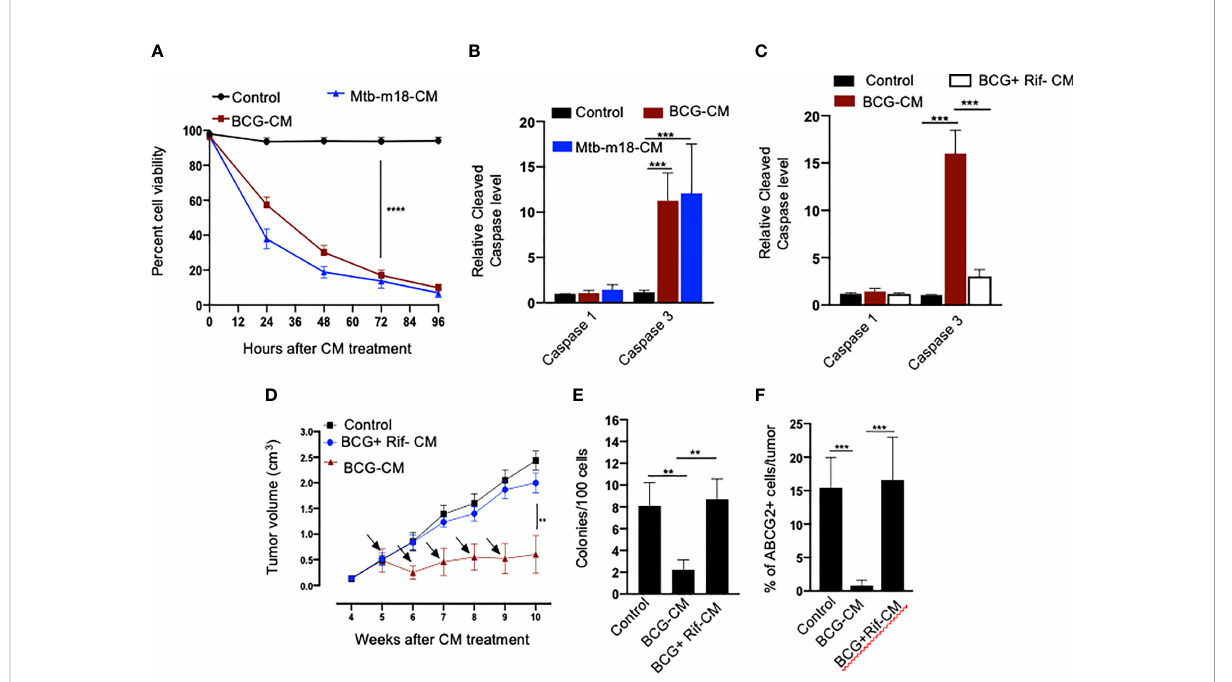
FIGURE 3 The CM of BCG-infected EpCAM+/ABCG2+ CSCs induces bystander apoptosis in non-infected EpCAM+/ABCG2+ CSCs. (A) Trypan blue assay of non- infected EpCAM+/ABCG2+ CSCs after treatment with BCG-CM or m18b-CM (CM of BCG/Mtb-m18b – infected EpCAM+/ABCG2+ CSCs grown for 12 days). (B, C) Cleaved caspase levels (ELISA) following 48 h of treatment with BCG-CM or BCG + Rif + CM [CM of BCG-infected EpCAM+/ABCG2+ CSCs treated with Rifampicin (Rif)]. (D) In vivo growth of tumor in a SCC-25 – derived xenograftmodel of NOD/SCID mice (n = 10 in each group)